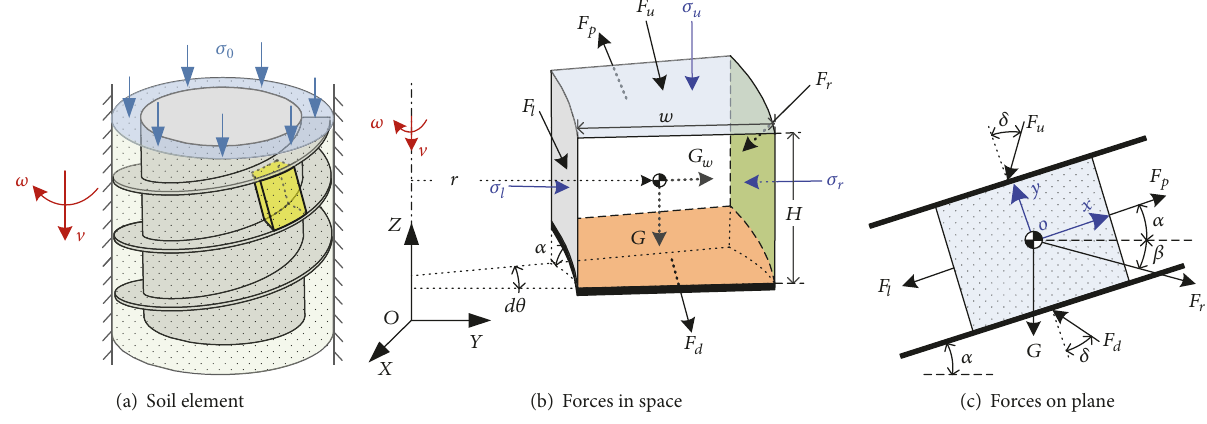
Figure 6: Forces analysis of chips